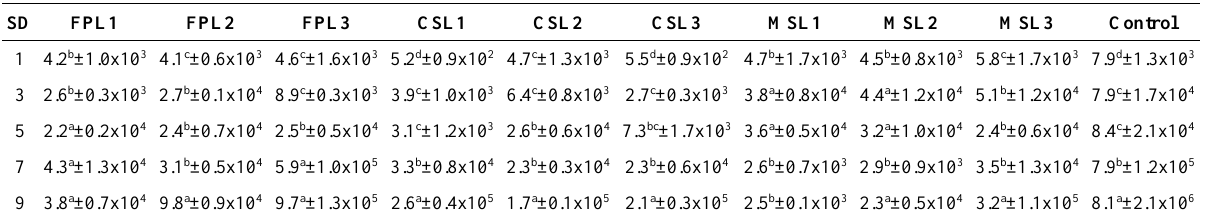
Table 4. Yeast and moulds counts (log CFU/g) in the ogiri samples during storage